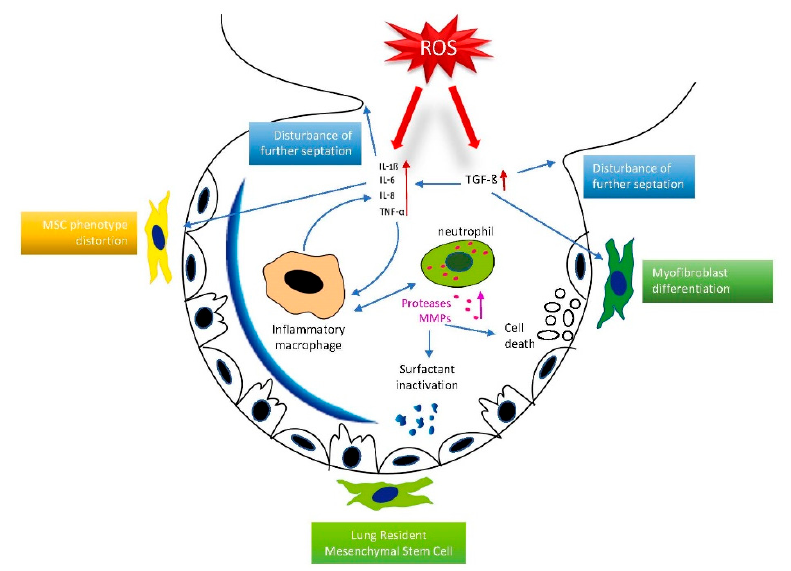
Figure 2. ROS-mediated pulmonary inflammatory response in the immature lung. Reactive oxygen species induce a pulmonary inflammatory response via overexpression of pro-inflammatory cyto- kines and attraction of inflammatory macrophages and neutrophils. Surfactant inactivation, cell death induction of lung cells, lung-resident mesenchymal stem cell phenotype distortion, and rare- fication of septation constitute the hallmarks of BPD’s